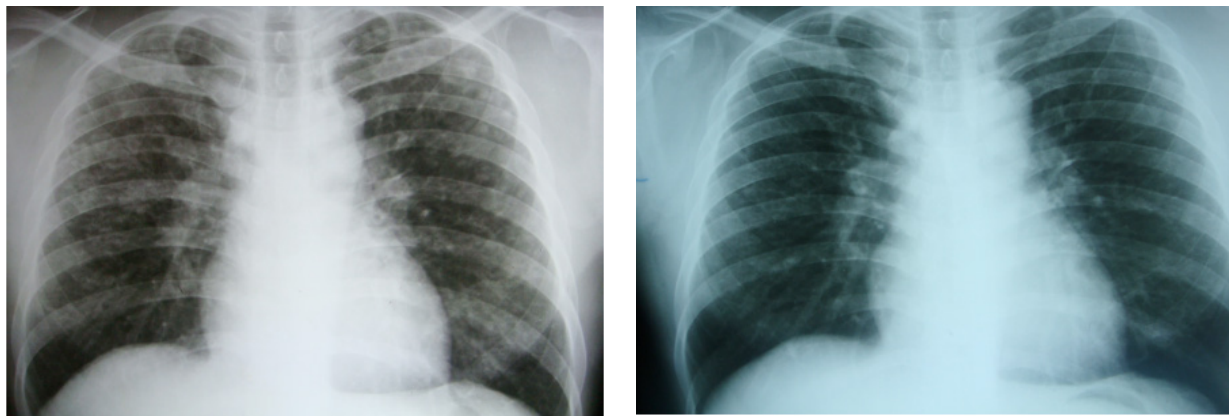
Figure 3A: PA view of Chest X-Ray showing multiple nodular opacities in both the lung fields with right hilar and paratracheal lymphadenop- athy. B. Same patient’s Chest X-ray after 1.5 months of treatment. X-ray shows faint reticulonodular shadows in bilateral upper and mid zones with normal hilar